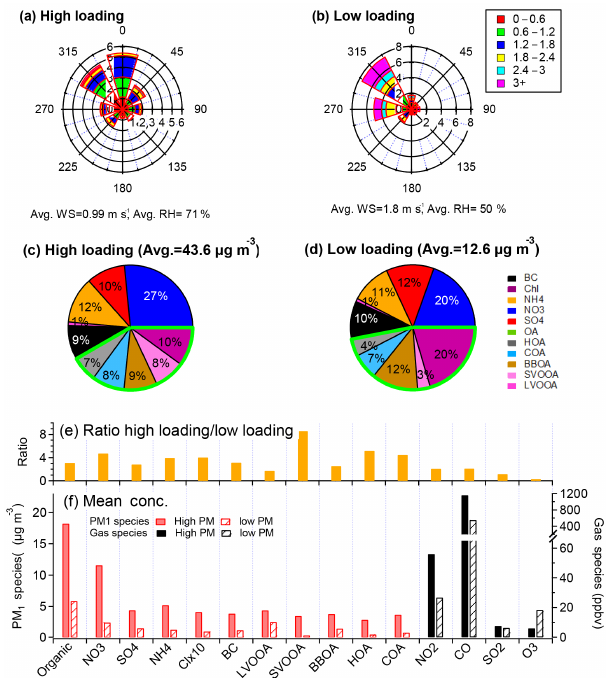
Figure 12. Comparisons of averaged properties measured during high particulate matter (PM), loading, and low-PM loading peri- ods; (a,b) wind rose plots, colored by wind speed for each different period; (c,d) fractional contributions of each species to the total PM 1 (nonrefractory PM 1 plus BC) mass; (e) ratios of absolute con- centrations of each PM 1 and gas species during high-loading and low-loading periods; (f) comparisons of averaged absolute concen- trations of PM 1 species and gaseous pollutants for each different